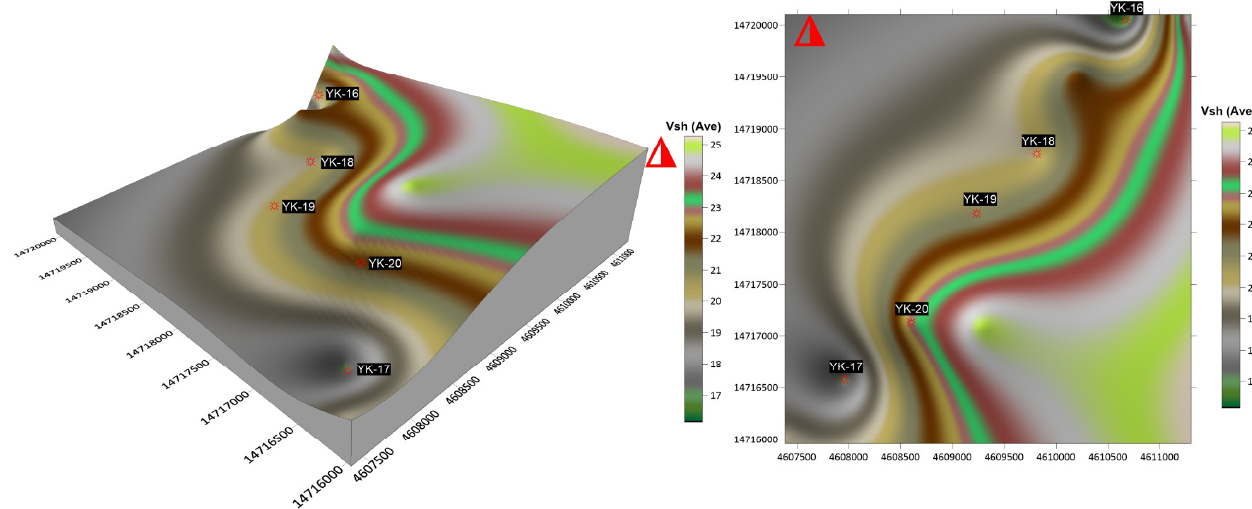
Figure 12. Shale volume variation map (calculated in %).